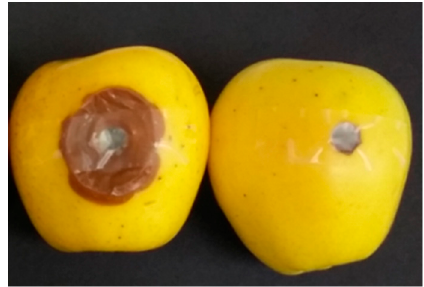
Figure 4. Apple fruits of cv. “Golden Delicious” inoculated with the virulent hybrid of O . novo - ulmi from P ă durea Verde-Timi ș oara showed the typically golden-brown circular lesion surrounding the inoculation point (left), whereas the control apples (right), inoculated with only sterile PDA plugs, did not display any fungal growth.